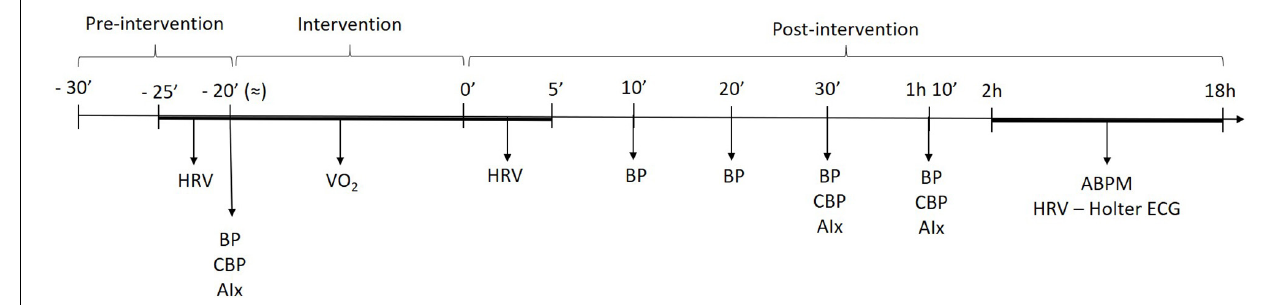
FIGURE 1 | Timeline of measurements across submaximal exercise and non-exercise sessions. HRV, heart rate variability; BP, blood pressure; cBP, central blood pressure, AIx, augmentation index; ABPM, ambulatory blood pressure